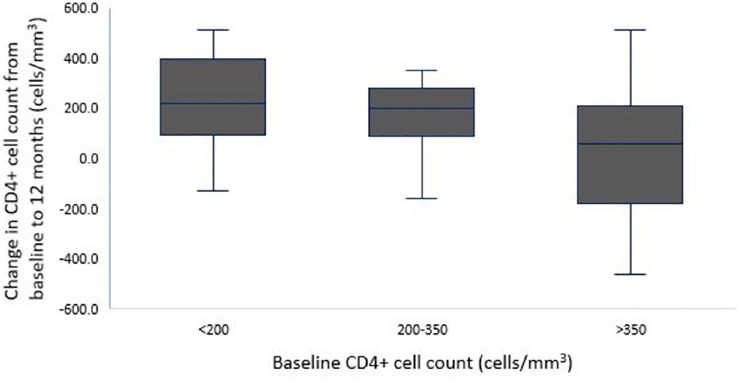
Fig 1. Median increase in CD4+ cell count from baseline to 12 months by baseline CD4+ cell